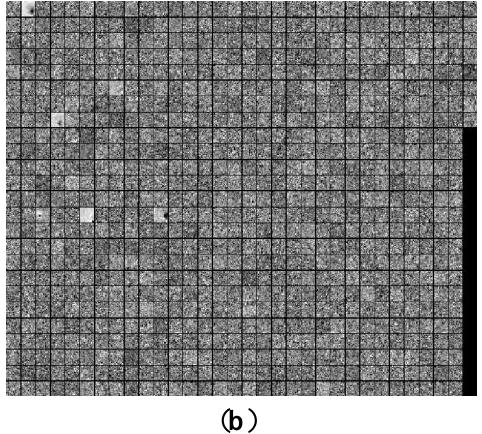
Figure 10. Discriminative over-complete dictionary. ( a ) and ( b ) are target dictionary and background dictionary for space image, respectively; ( c ) and ( d ) are target dictionary and background dictionary for cloud image, respectively; ( e ) and ( f ) are target dictionary and background dictionary for multi-target image,